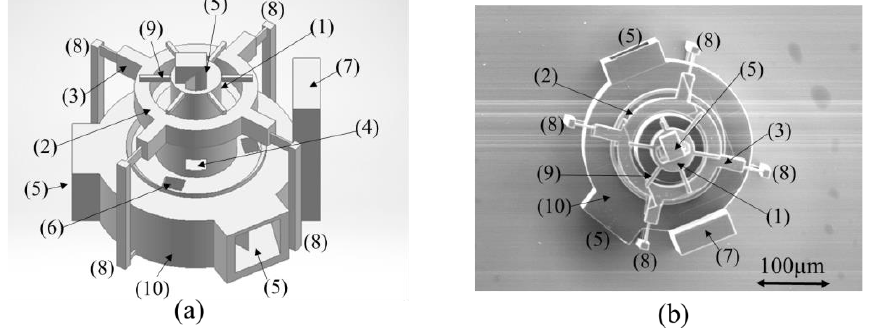
Figure 3. Friction-reduction confirmation experimental apparatus. (1) Shaft, (2) Rotating ring, (3) Hand, (4) Aperture-1, (5) Entrance of light, (6) Aperture-2, (7) Fiber stand, (8) Support, (9) Ring stopper, (10) Base, ( a ) Three-dimensional CAD model, ( b ) Scanning electron microscope (SEM) im- age of experimental